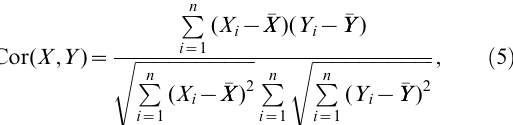
ffiffiffiffiffiffiffiffiffiffiffiffiffiffiffiffiffiffiffiffiffiffiffiffiffiffi P